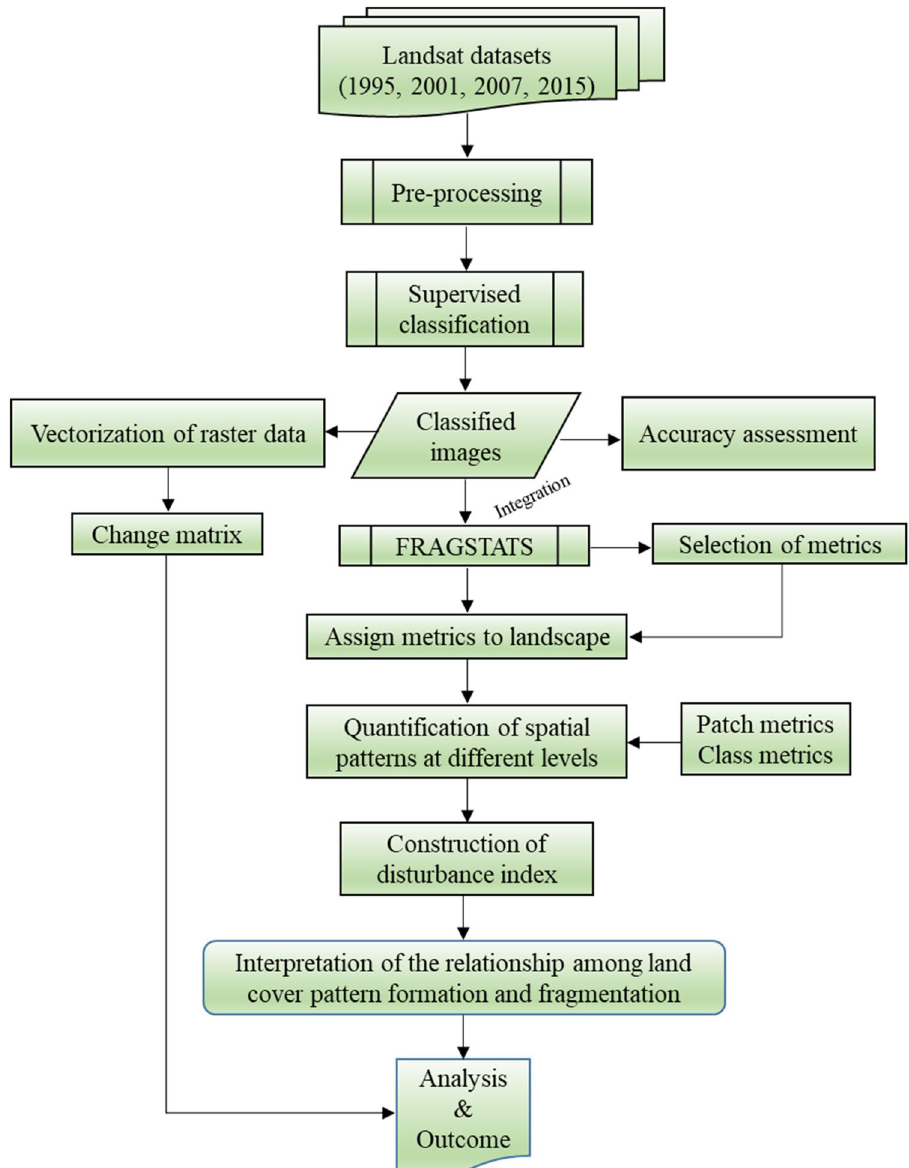
Fig. 2 Flowchart of methodol- ogy